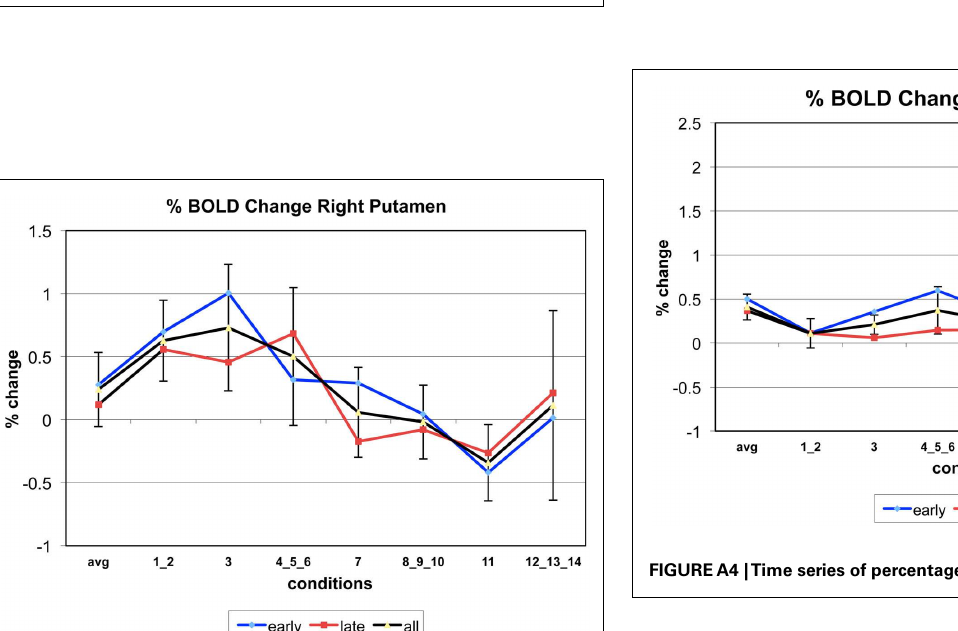
FIGUREA1 |Time series of percentage BOLD change for G(15,3).